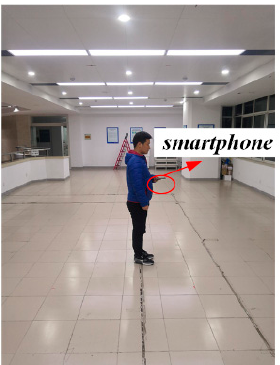
Figure 13. Diagram of smartphone’s position during experiment.